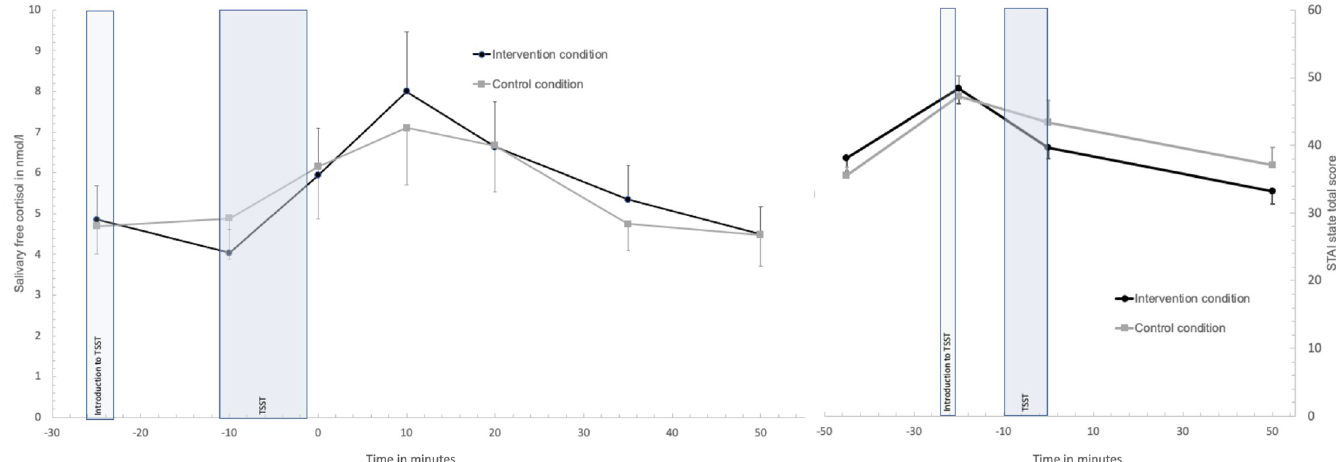
Fig 2. Salivary free cortisol and state anxiety responses in the Trier Social Stress Test between conditions. Values are means and standard error means.